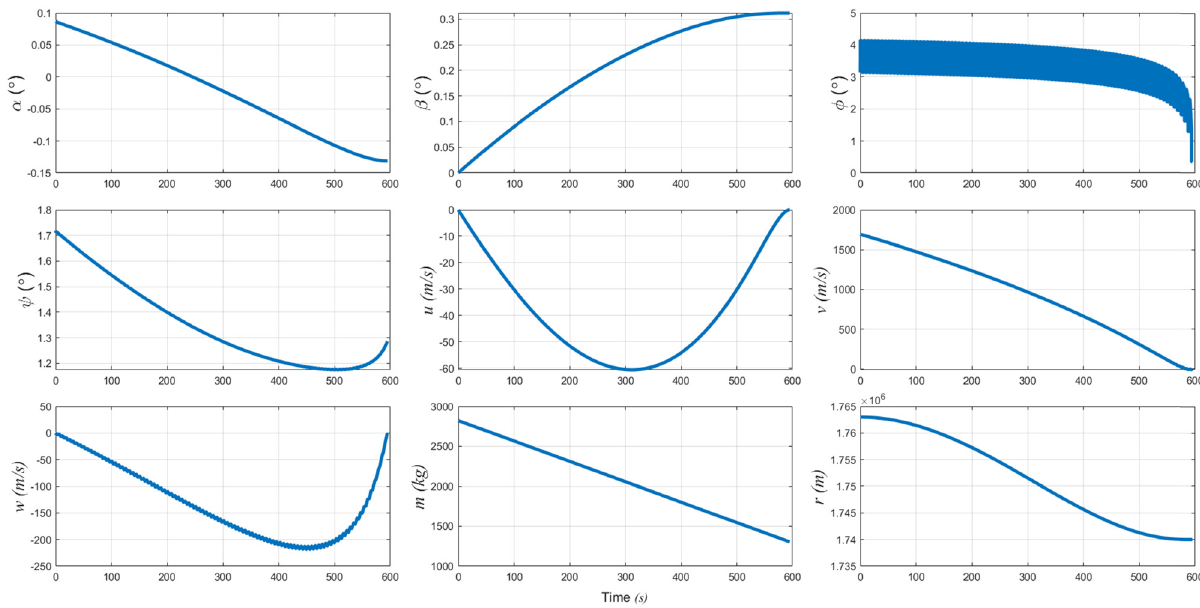
Figure 7: Latitude, longitude, attitude angle, velocities, and distance of the PID + PWM